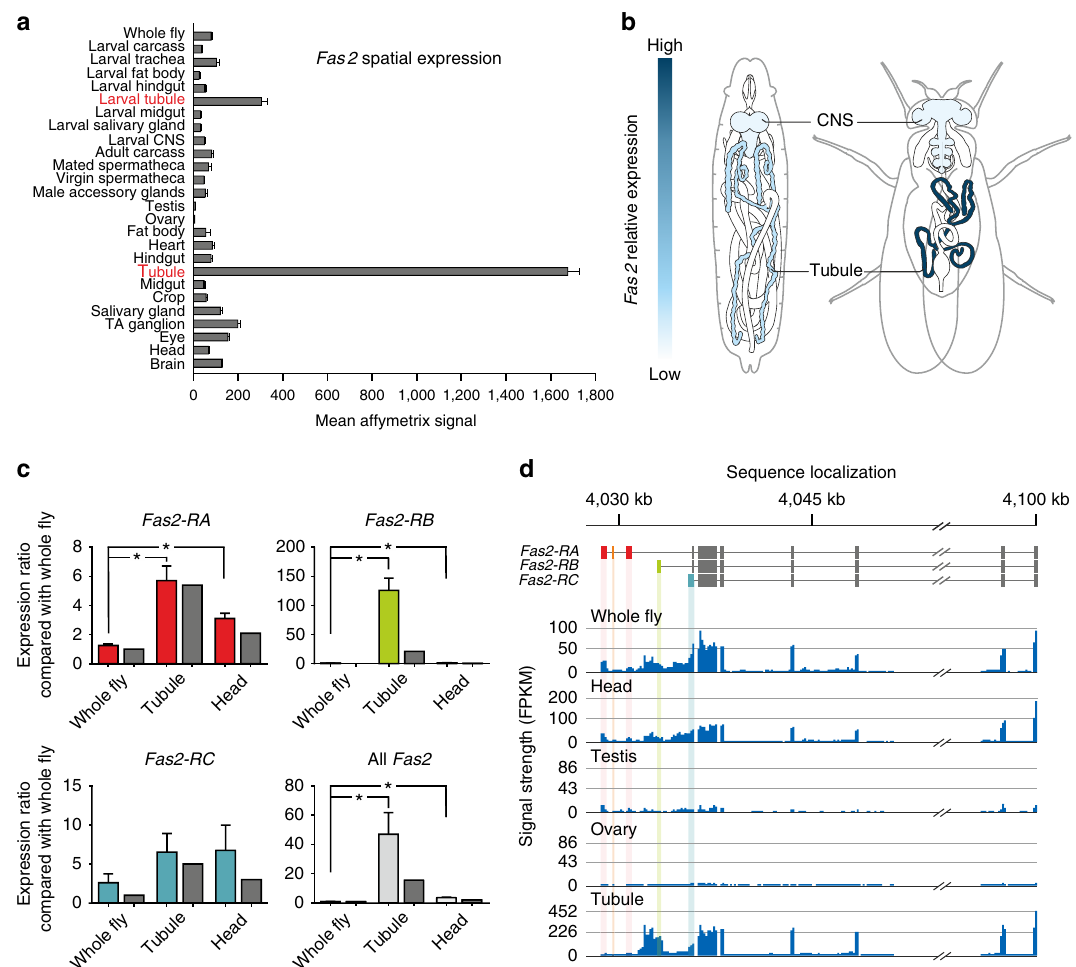
Figure 1 | Transcriptomic profiling of Fas2 expression. ( a ) Mean normalized Affymetrix signal ± s.e.m. ( N ¼ 4 tissue samples) showing the Fas2 spatial expression pattern across major tissues from both larval and adult Drosophila (flyatlas.org). ( b ) Overview of Drosophila anatomy with superimposed heat maps of the spatial expression pattern of Fas2 . ( c ) Microarray and qPCR analyses of the dominant Fas2 isoforms across different tissues. The Affymetrix whole fly signal (dark grey bars) was set to an a.u. of 1, with head and tubule signals being expressed as a ratio to whole fly. The mean ± s.d. qPCR expression ratios (light grey bars) largely reiterate the microarray data, albeit show much higher Fas2 - RB transcript enrichment in MTs compared with the Affymetrix signal. *Significantly different (one-way ANOVA, P o 0.05) compared with whole fly. ( d ) RNA-Seq data comparing Fas2 transcript levels across different tissues. The combined transcriptomic meta-analysis reveal that Fas2-RA , RB and RC are the main isoforms expressed in Drosophila , with isoform Fas2-RB being the dominant splice variant expressed in the